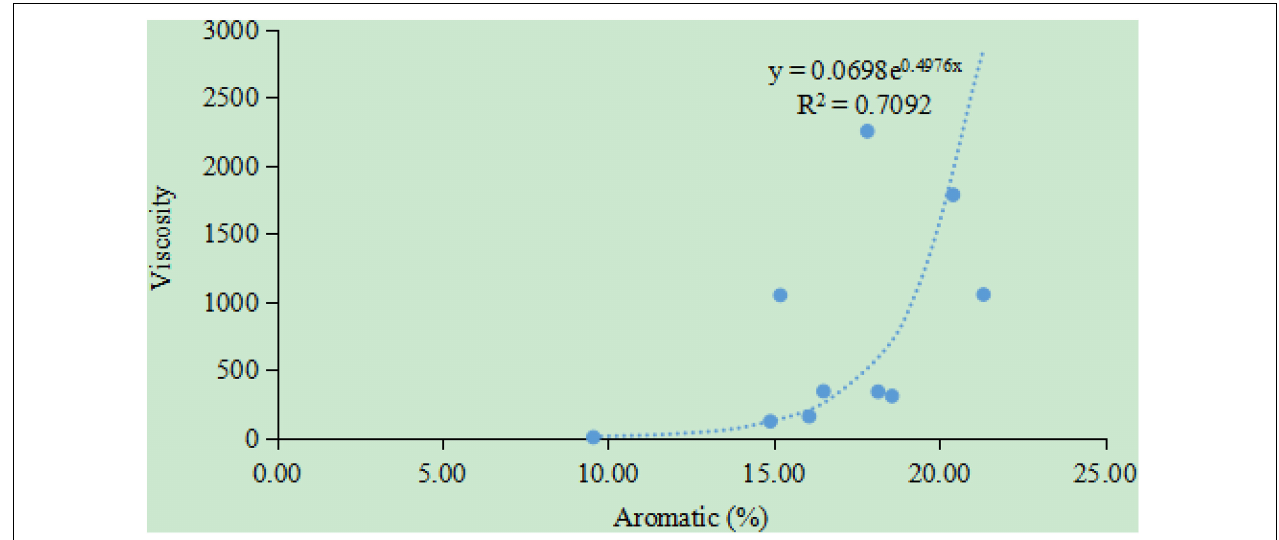
FIGURE 4 | Relationship between the content of the aromatic hydrocarbon and the viscosity (20 ◦ C) for crude oil extracted from the Jimsar Sag (the crude oil data were provided by the Xinjiang Oilfield Company of CNPC).